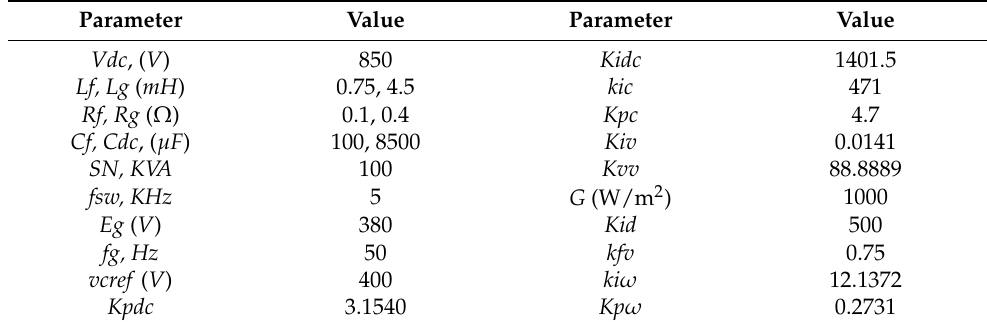
Table 1. Steady-state parameters of the system.